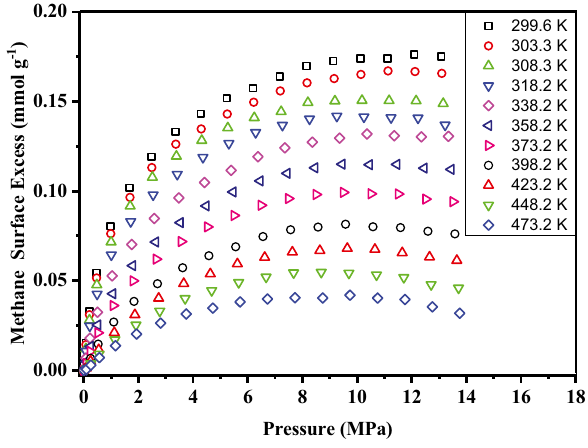
Fig. 2 Supercritical methane adsorption isotherms for Alum 1 shale for temperatures in the range 299.6–473.2 K (data from [35])